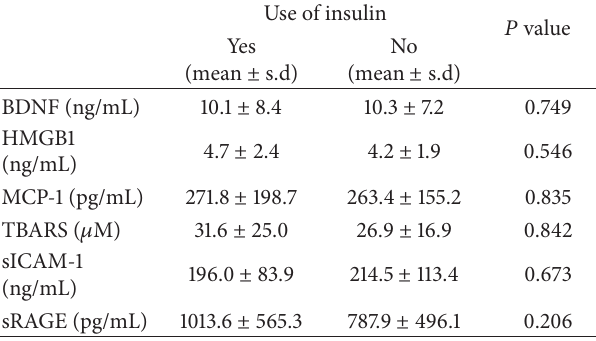
Table 3: Relationship between serum levels of the studied factors and type of diabetes treatment in patients with proliferative diabetic